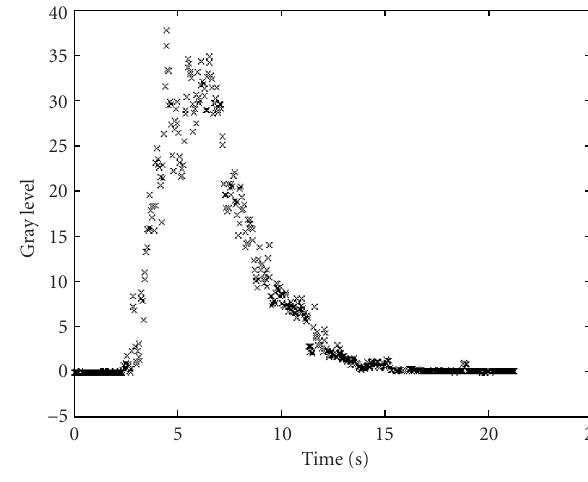
Figure 4: Example of noisy